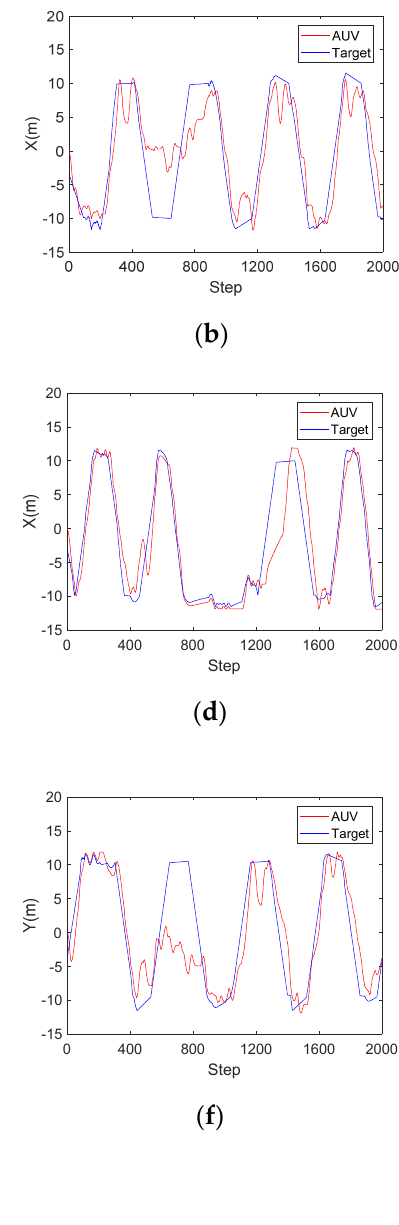
( h ) Figure 7. The coordinate change curves in Scene 2 during the process of AUV tracking the target using PPO, SAC, GAIL, and MAG, respectively: ( a – d ) the X-coordinate change; ( e – h ) the Y-coordi- nate change. Figure 8 shows the trajectory of the AUV and the target using four methods in Scene 3. It can be seen that the control effect of the four methods becomes significantly worse than in Scene 1. It shows that the AUV acts more cautiously when colliding with an ob- stacle is negatively rewarded. In Figure 8a,b,e,f, the AUV hesitated for a long time and went further and further away from the target when using PPO or SAC. When using the GAIL controller, the trajectory of the AUV and the target is quite different in the whole tracking process; it is considered that the AUV cannot complete the task of tracking the target. Compared with other methods, the MAG controller makes the AUV track the tar- get for the longest time. The tracking effect is also better than that of the other three meth- ods.